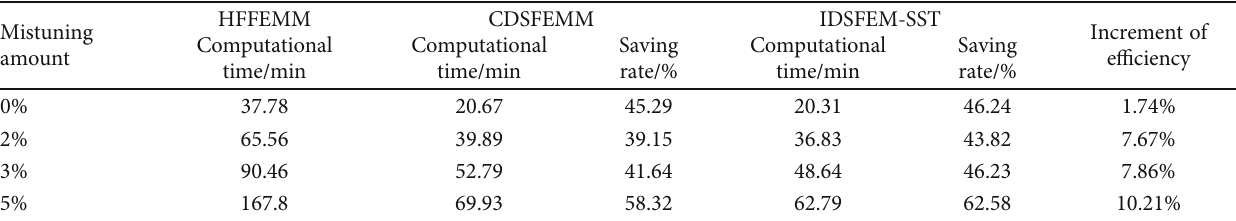
Figure 11: Radial frequency response functions of mistuned blisk. A Table 3: Computational time and saving rate of vibratory